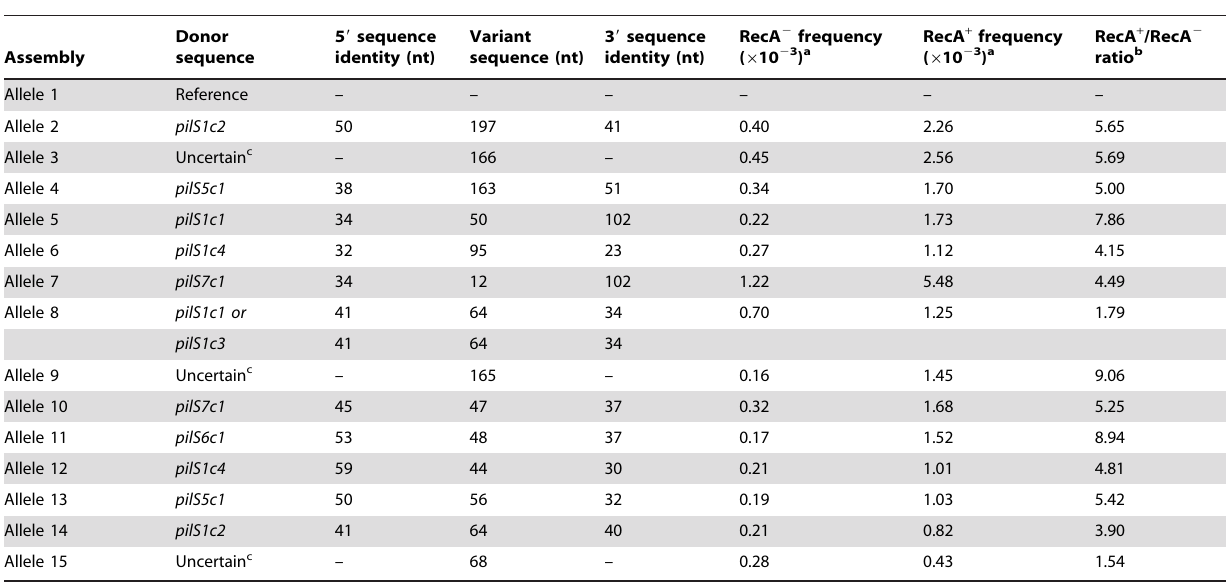
Table 5. Variant sequences detected in the first experiment with pilE from N. gonorrhoeae MS11.